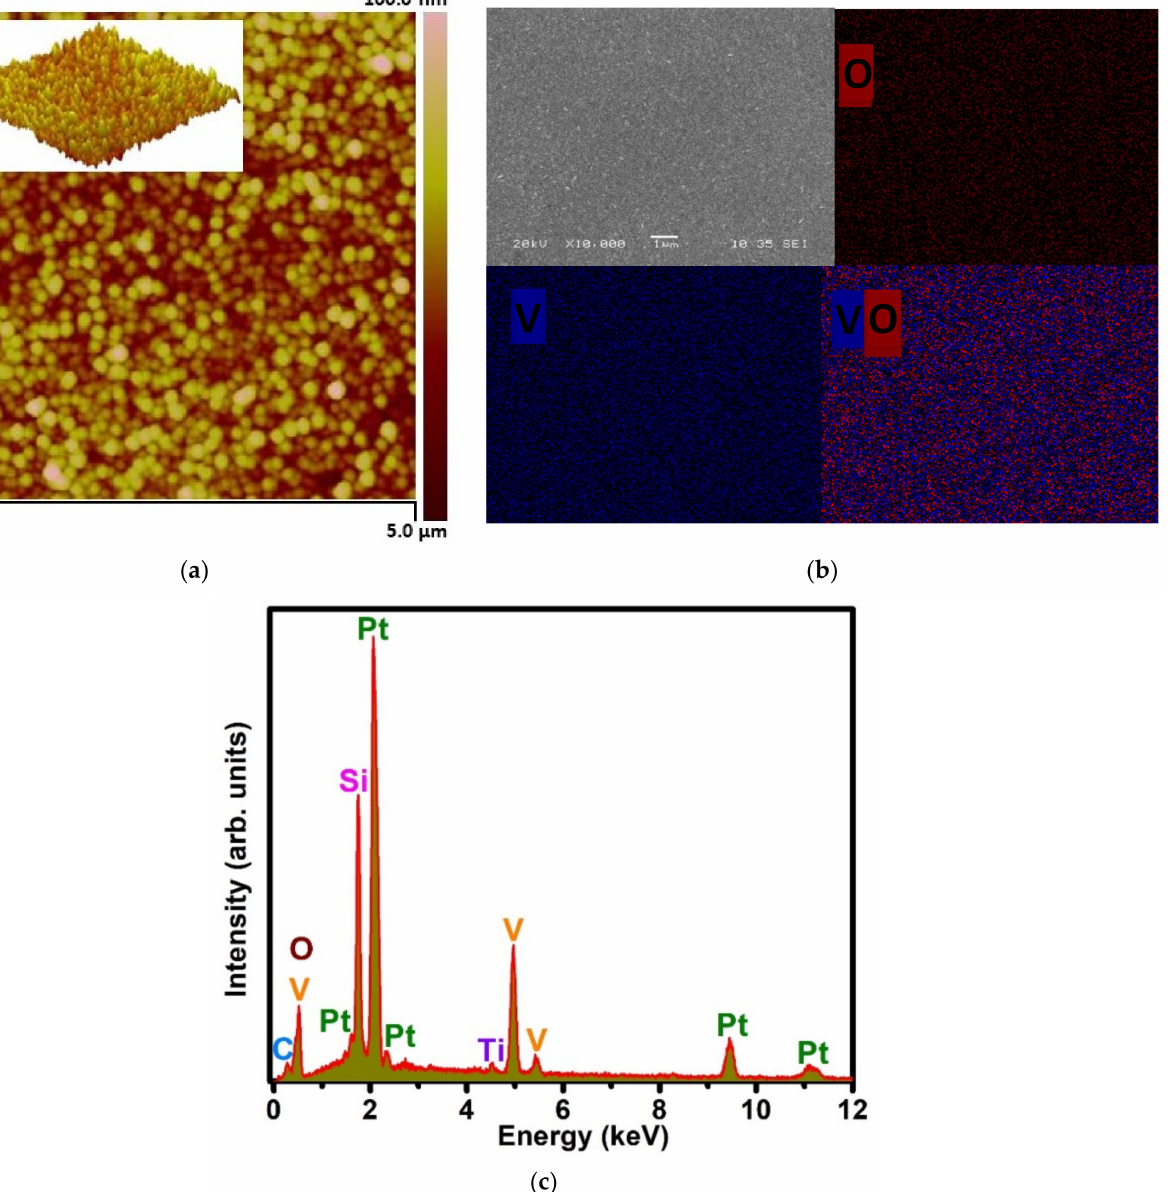
Figure 2. ( a ) AFM micrograph of a V 2 O 3 film at 100 nm in Z-scale (Inset: 3D AFM image) ( b ) SEM micrograph and distribution maps of elements V and O, as well as their sum total mapping of surface area ( c ) EDS spectrum of theV 2 O 3 thin films shows the presence of all constituent elements at their respective characteristic energy